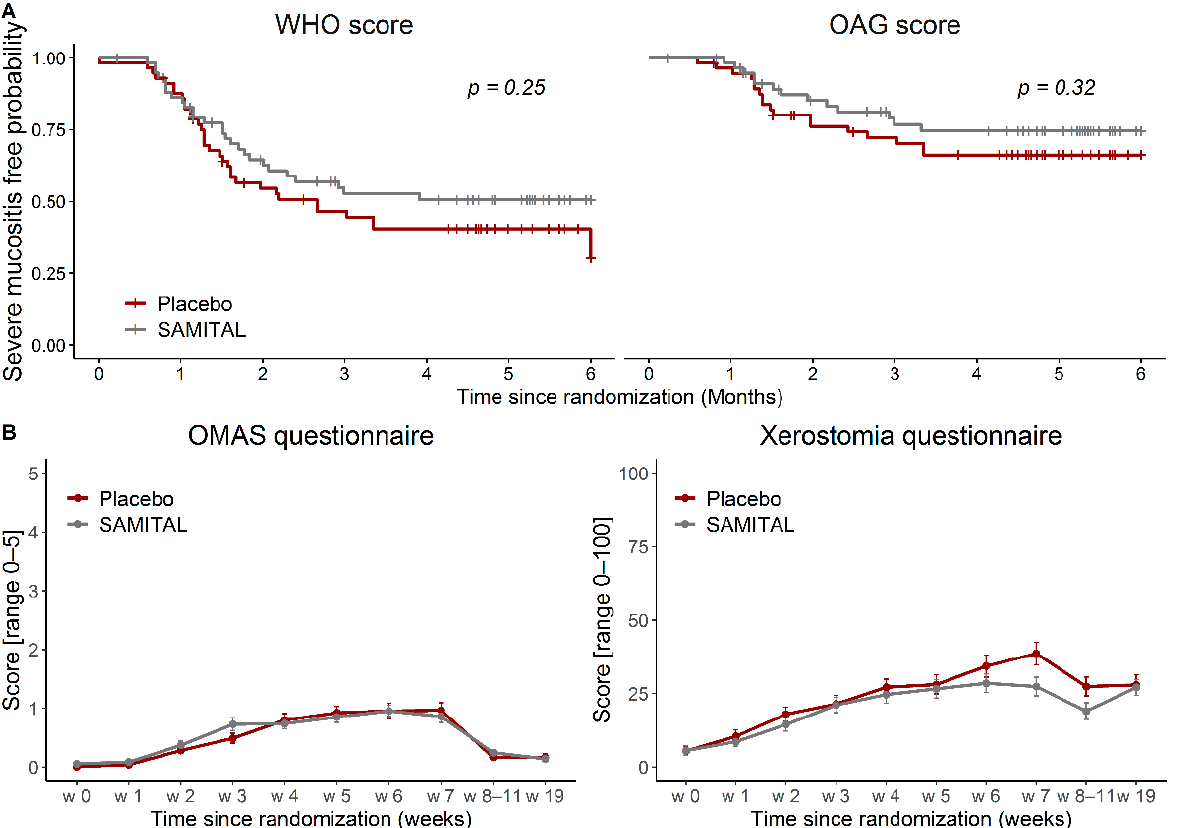
Figure 2. ( A ) Severe mucositis-free probability as time from randomization to the occurrence of a grade 3/4 mucositis, as measured by the WHO score, or to the occurrence of a severe oral condition, as measured by an OAG score > 17. ( B ) Scores over time for the OMAS and the Xerostomia Questionnaire. Data are presented as estimated mean scores (repeated-measure models) at every time point, with their 95% confidence interval. A higher score indicates a worse oral condition. WHO, World Health Organization; OAG, Oral Assessment Guide. OMAS, Oral Mucositis Assessment Scale.